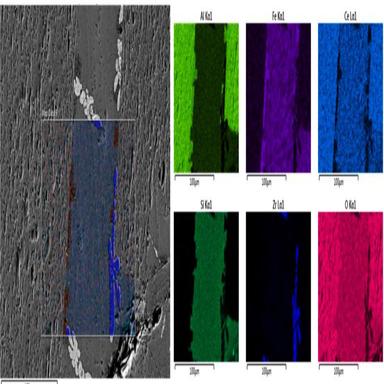
Different features and arrangement of constitutional compounds.